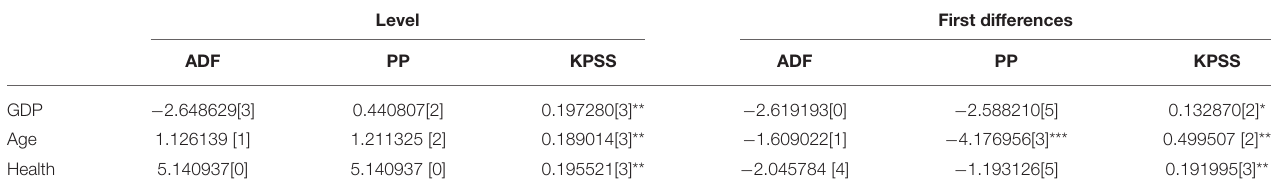
TABLE 2 | Univariate unit root tests.